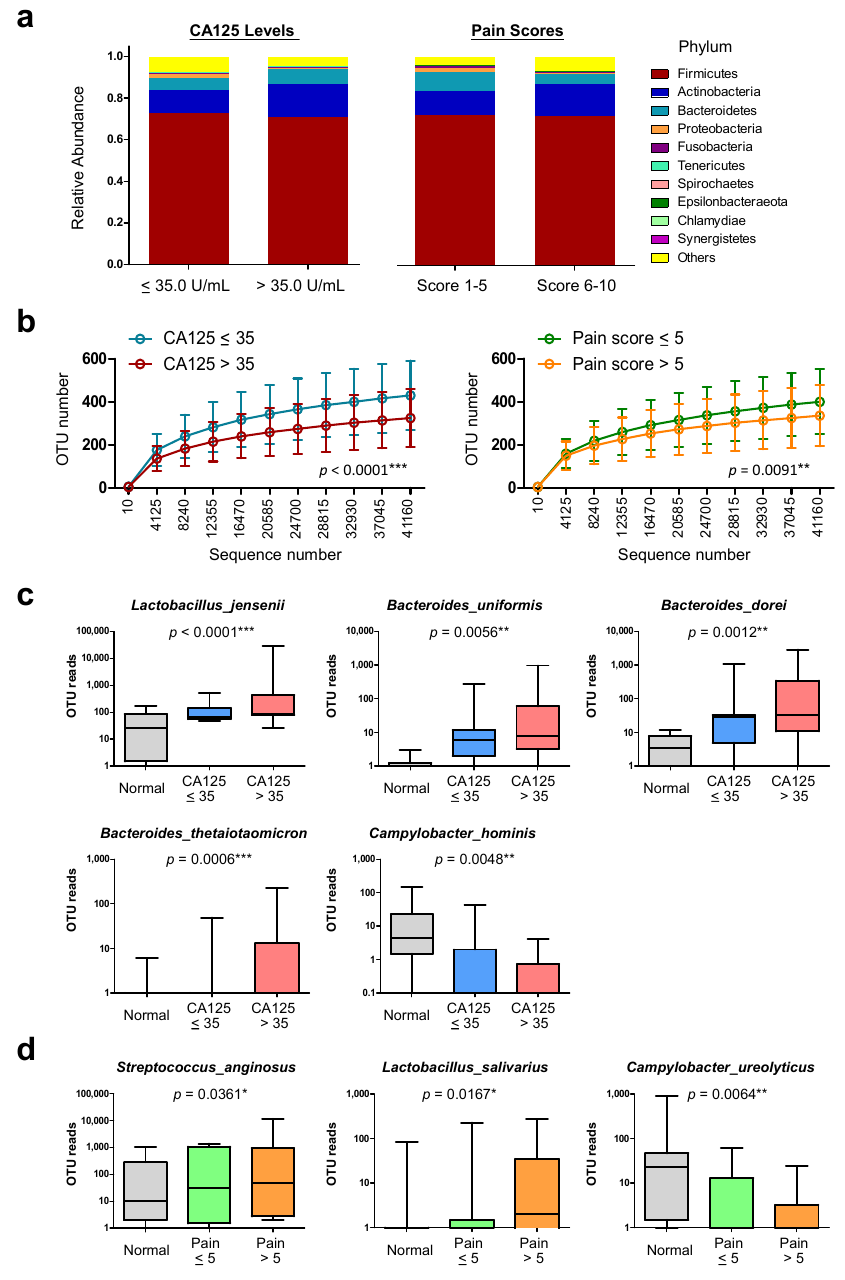
Figure 4. Abundance and composition of cervical microbiomes in endometriosis patients with different CA125 levels and pain scores. ( a ) Relative abundance of the top-10 major phyla of cervical microbiomes in patients with different CA125 levels ( left ) and pain scores ( right ). ( b ) The rarefaction curves indicate the differences in biodiversity (accumulated OTU numbers) of group samples accord- ing to CA125 levels ( left ) or pain scores ( right ). Statistics were performed with two-way ANOVA method. One-way ANOVA was performed to define the major down-regulated or up-regulated microbes in cervical mucus of patients that associated with ( c ) higher CA125 levels or ( d ) higher pain scores. Statistical significance: *, p < 0.05; **, p < 0.01; ***, p <